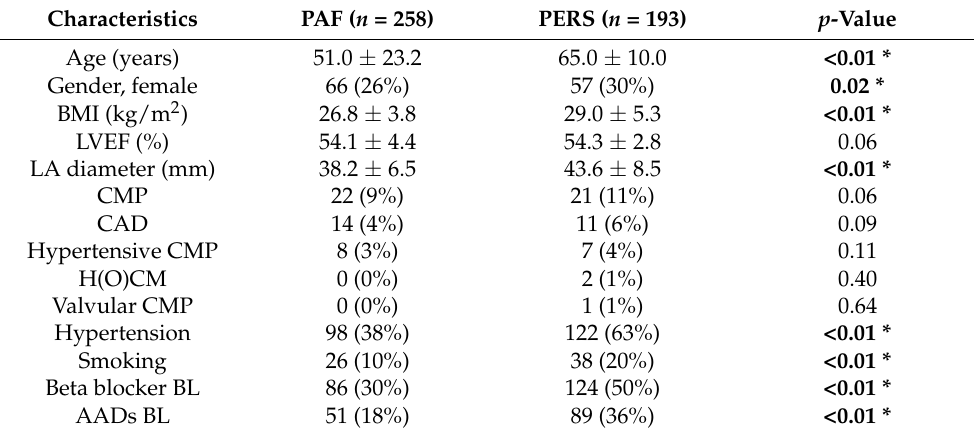
Table 1. Baseline Characteristics.